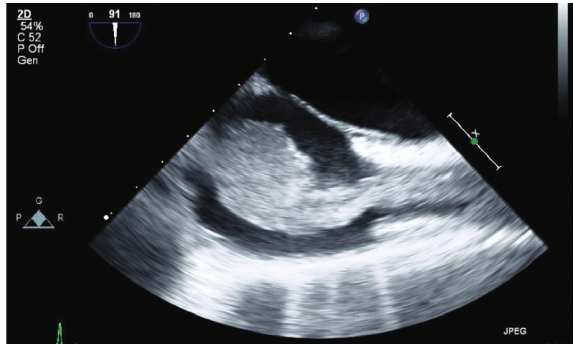
Figure 1: Transesophageal Echocardiogram (TEE) midesophageal bicaval view: large lobulated mobile mass extending from the superior vena cava (SVC) into the right atrium.